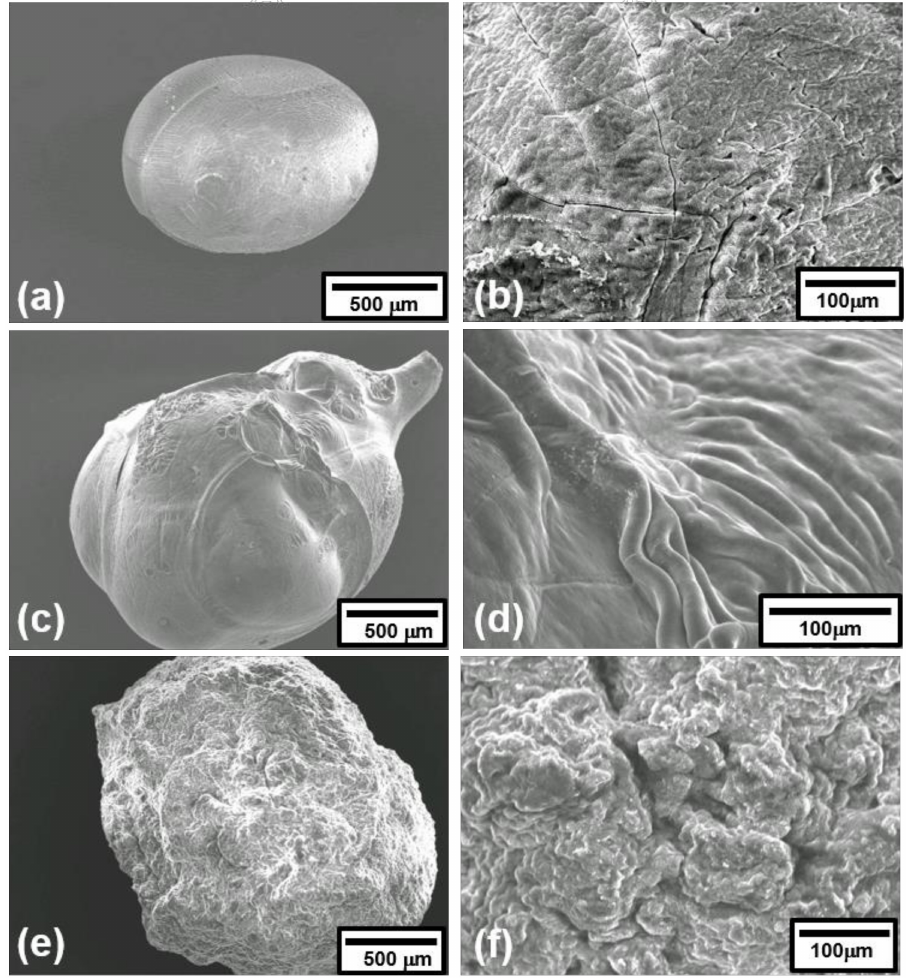
Figure 3. SEM images of xerogel alginate beads following incorporation of Ag + ions: ( a , b ) are CaALG/Ag + (0.1 M); ( c , d ) are CaALG/PGA/HSA/Ag + (0.1 M); ( e , f ) are CaALG/QA/Ag + (0.1